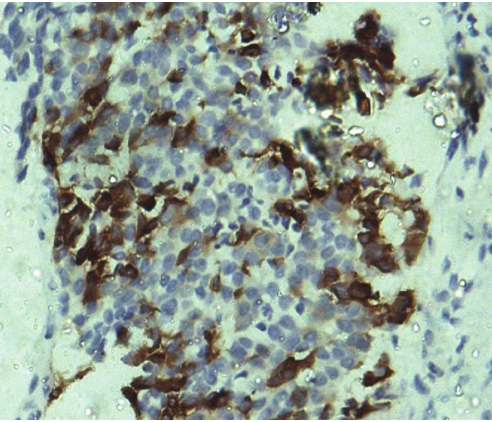
Figure 3: Photomicrograph showing tumor cells positive for syn- aptophysin.